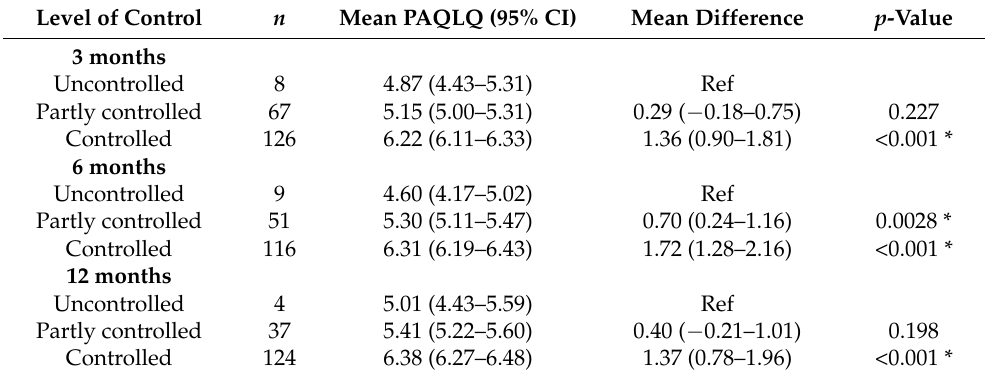
Table 4. PAQLQ score distribution by level of asthma control at each follow-up visit.